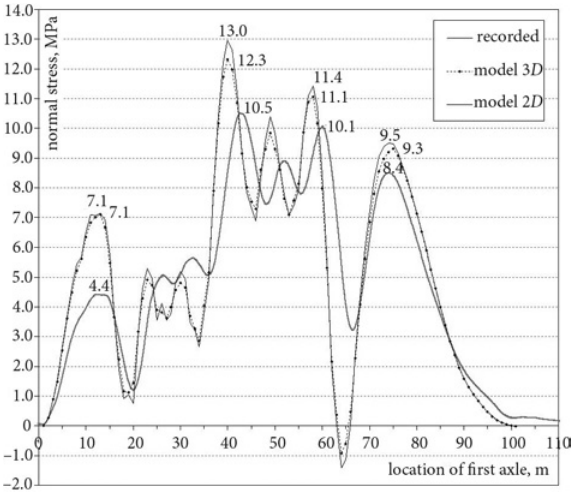
Fig. 12. Strain variations at top fibre of truss bottom Table 2. Equivalent of cross-sectional area of bottom flange members in 2 D computational model Model element